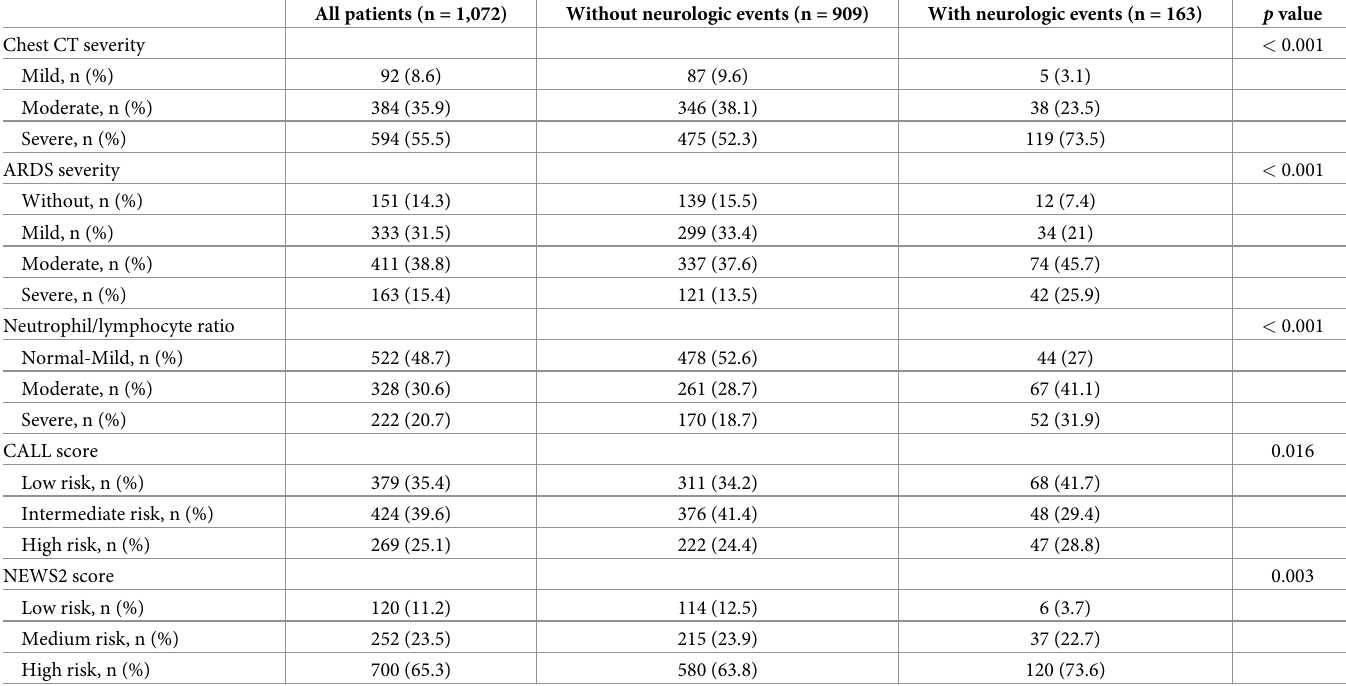
Table 2. Disease severity at hospital admission in patients hospitalized with moderate to severe COVID-19. All patients (n =